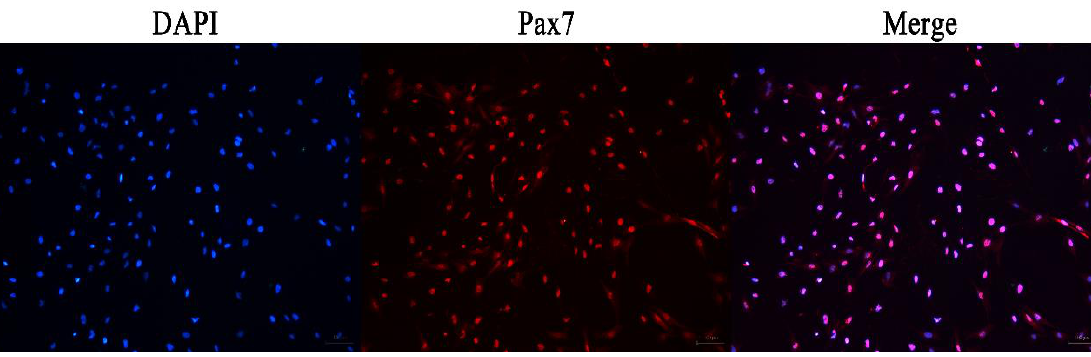
Figure 2. Immunofluorescence detection the expression of PAX7 protein in primary equine SCs.